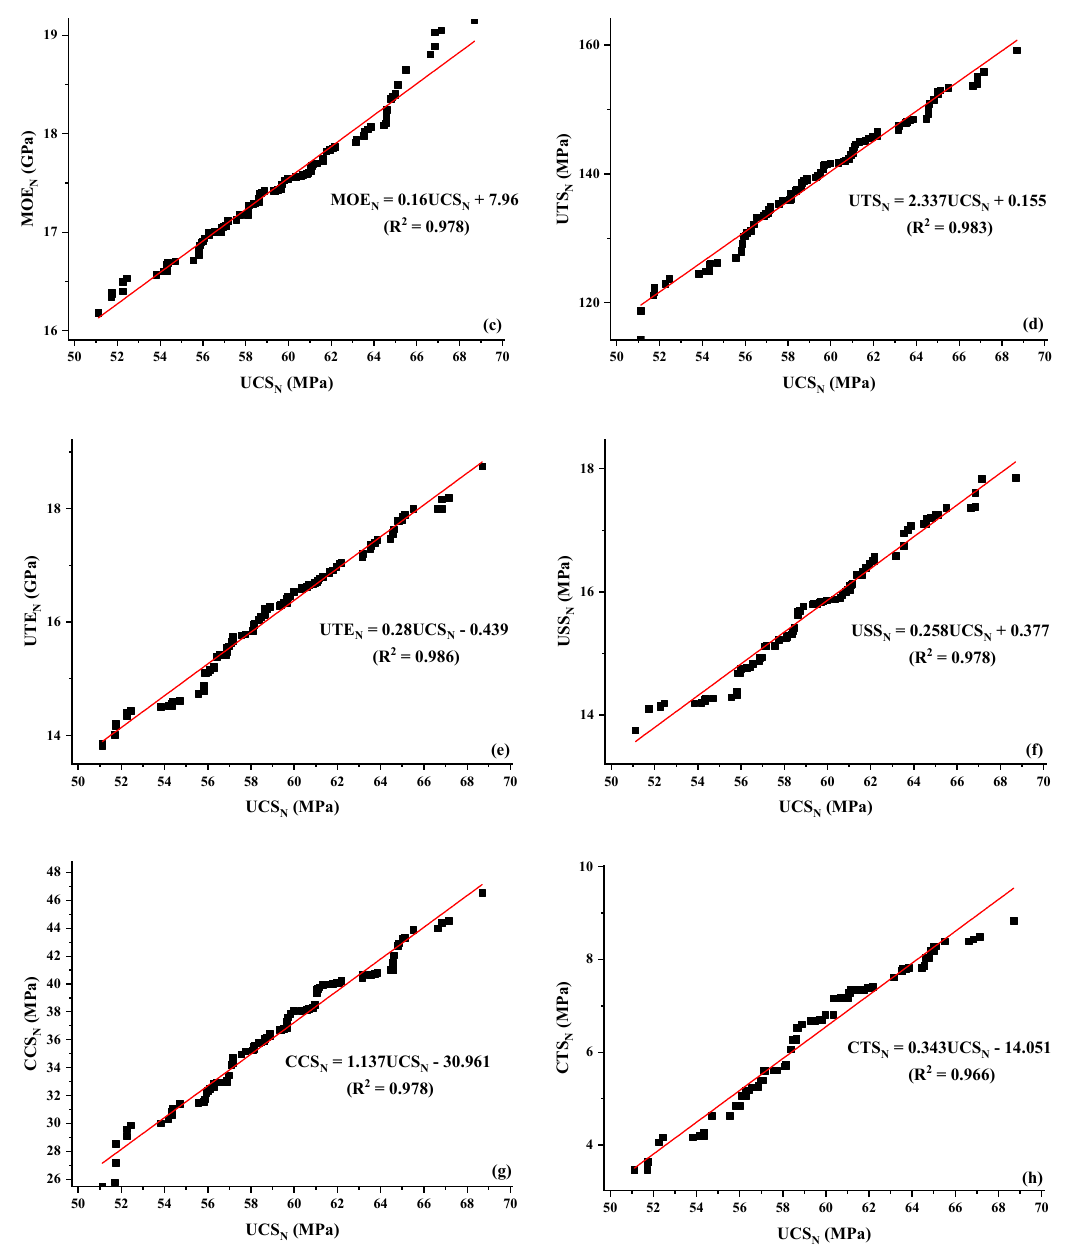
Figure 10. Relationship between the mechanical properties of the node specimens and UCS N. ( a ) UCE; ( b ) MOR; ( c ) MOE; ( d ) UTS; ( e ) UTE; ( f ) USS; ( g ) CCS; ( h ) CTS. The relationship between the mechanical properties was derived by the above method, and the relationship between the mechanical properties and the standardized parameter h/D B was derived by using the linear relationship between mechanical properties and the standardized parameter h/DB. Formula (9) is used as the conversion formula between mechanical properties. α and β are defined as the conversion parameters of the bamboo’s mechanical properties by considering the effect of bamboo nodes, as shown in Tables 5 and 6: